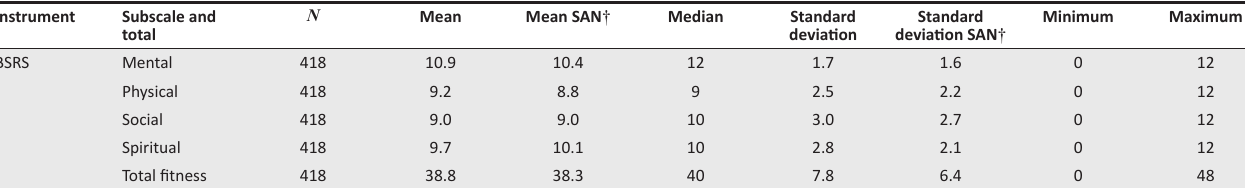
TABLE 3: Brief Sailor Resiliency Scale descriptive statistics .